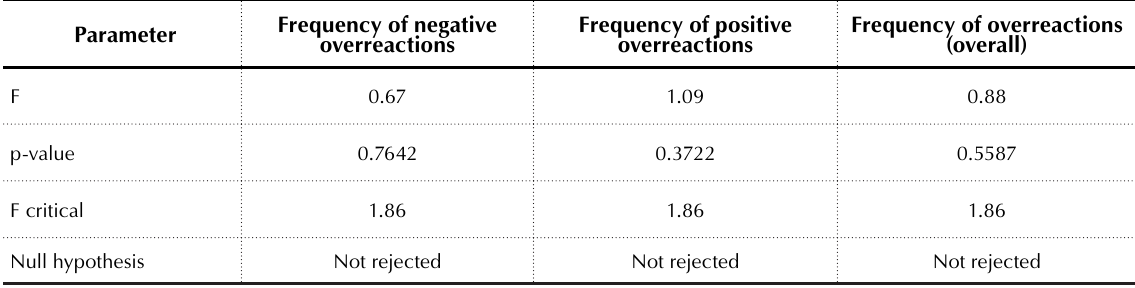
Table 8. Parametric ANOVA of monthly seasonality in overreactions frequency